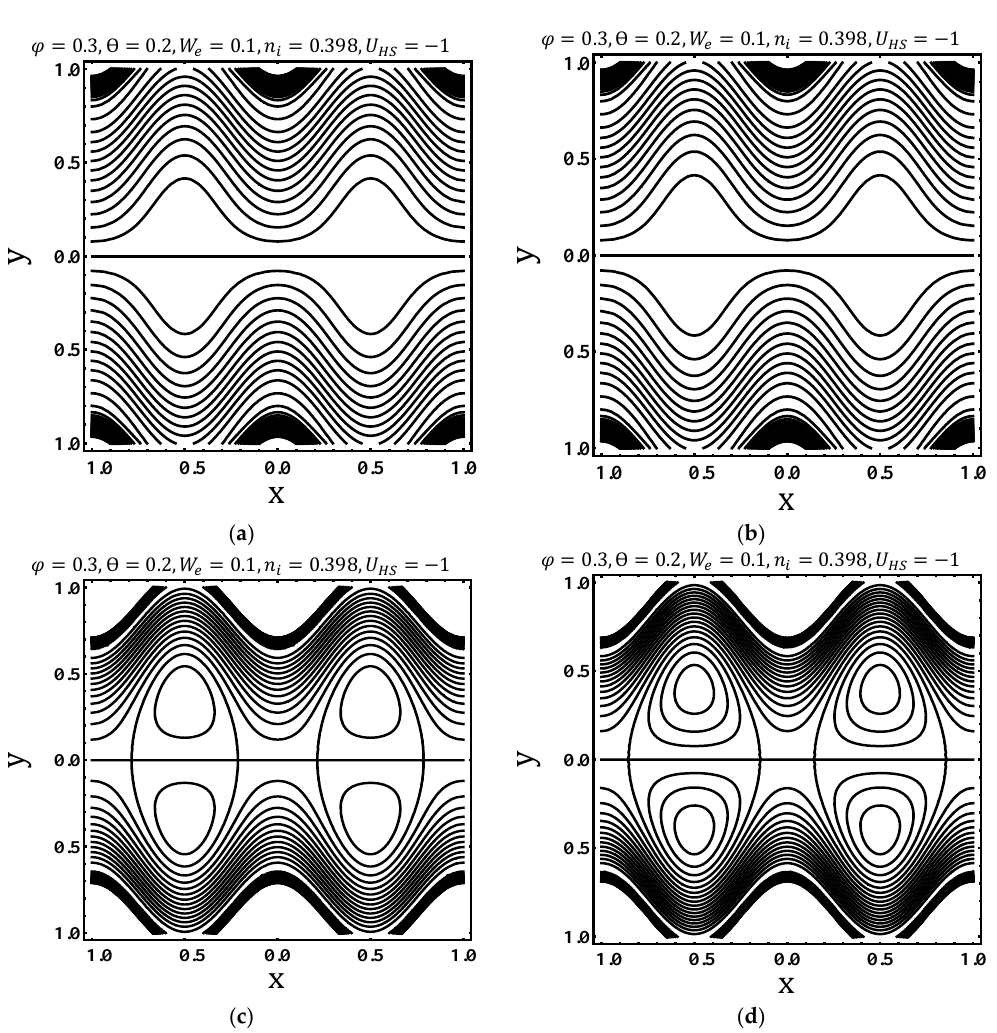
Figure 7. Streamline distribution for ( a ) m e = 2; ( b ) m e = 5; ( c ) m e = 10; ( d ) m e = 15. 𝜑 = 0.3,Ѳ = 0.2,𝑚 𝑒 = 2,𝑛 𝑖 = 0.398,𝑊 𝑒 = 0.1